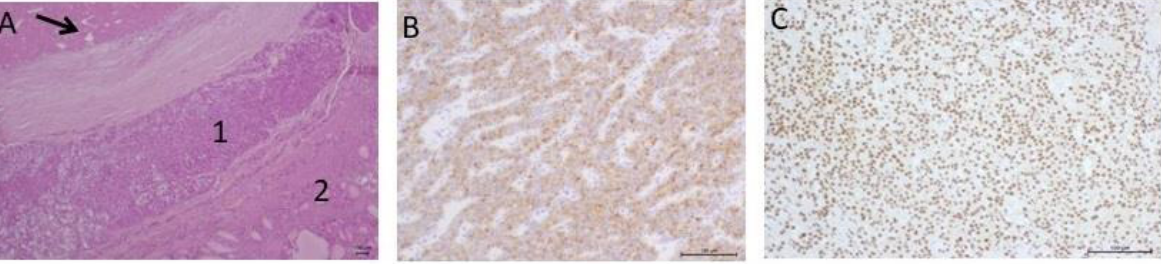
Figure 1. Parathyroid carcinoma. ( A ) Parathyroid carcinoma (1) with a focus of necrosis ( → ) invading the thyroid tissue (2); ( B ) Diffuse expression of PTH in the tumor with heterogeneous intensity in different cell pools; ( C ) Diffuse nuclear expression of parafibromin.